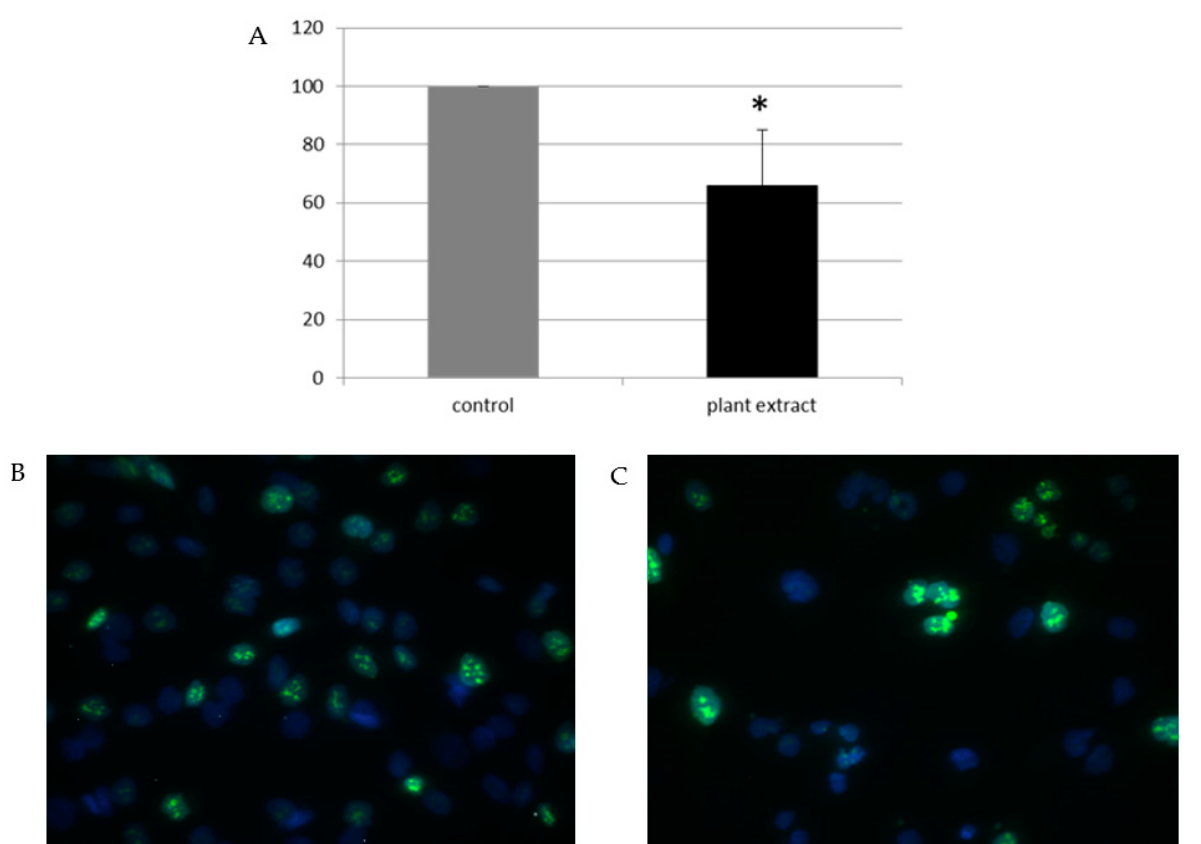
Figure 4. The effect of A. cerefolium methanolic extract on expression of Ki67 in A172 cell line; ( A ) The number of Ki67 positive cells in cells treated with the extract is presented as fold change of the number of Ki67 positive cells in cells treated with vehicle (DMSO) (arbitrarily set at 100%). Results are presented as the mean ± SD of three independent experiments, * p < 0.05 ( B ) A representative image of Ki67 immunostaining in the control cells treated with vehicle solvent DMSO; ( C ) A representative image of Ki67 immunostaining in cells treated with the extract. Nuclei are counterstained with DAPI.